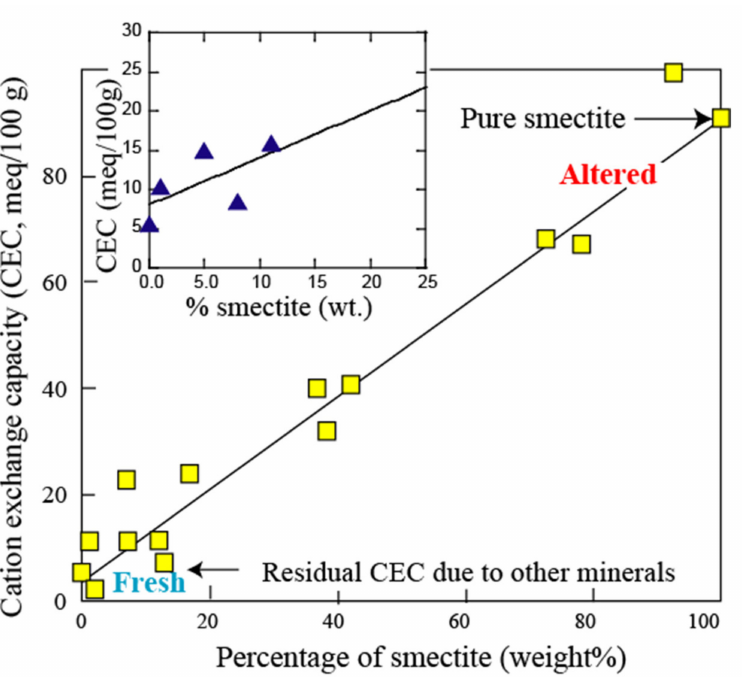
Figure 8. Influence of the smectite content (from XRD, X-Ray Diffraction measurements) in volcanic rocks versus their CEC (modified from Revil et al. [52]). This plot confirms that the smectite content controls the CEC of the volcanic rocks and therefore both surface conductivity and normalized chargeability. The insert concerns the data obtained by Revil et al. (2002, see their Tables 1 and 2 [37]) for zeolized volcaniclastic rocks (CEC obtained by the cobalt hexamine